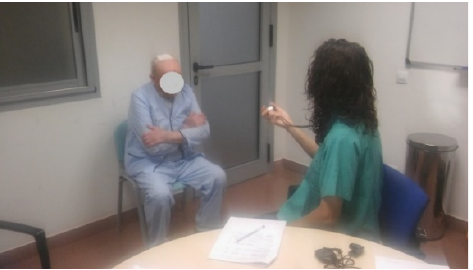
Figure 9. STS-10 and STS 60 Tests (reproduced with permission from Erika Mel é ndez-Oliva 2020)